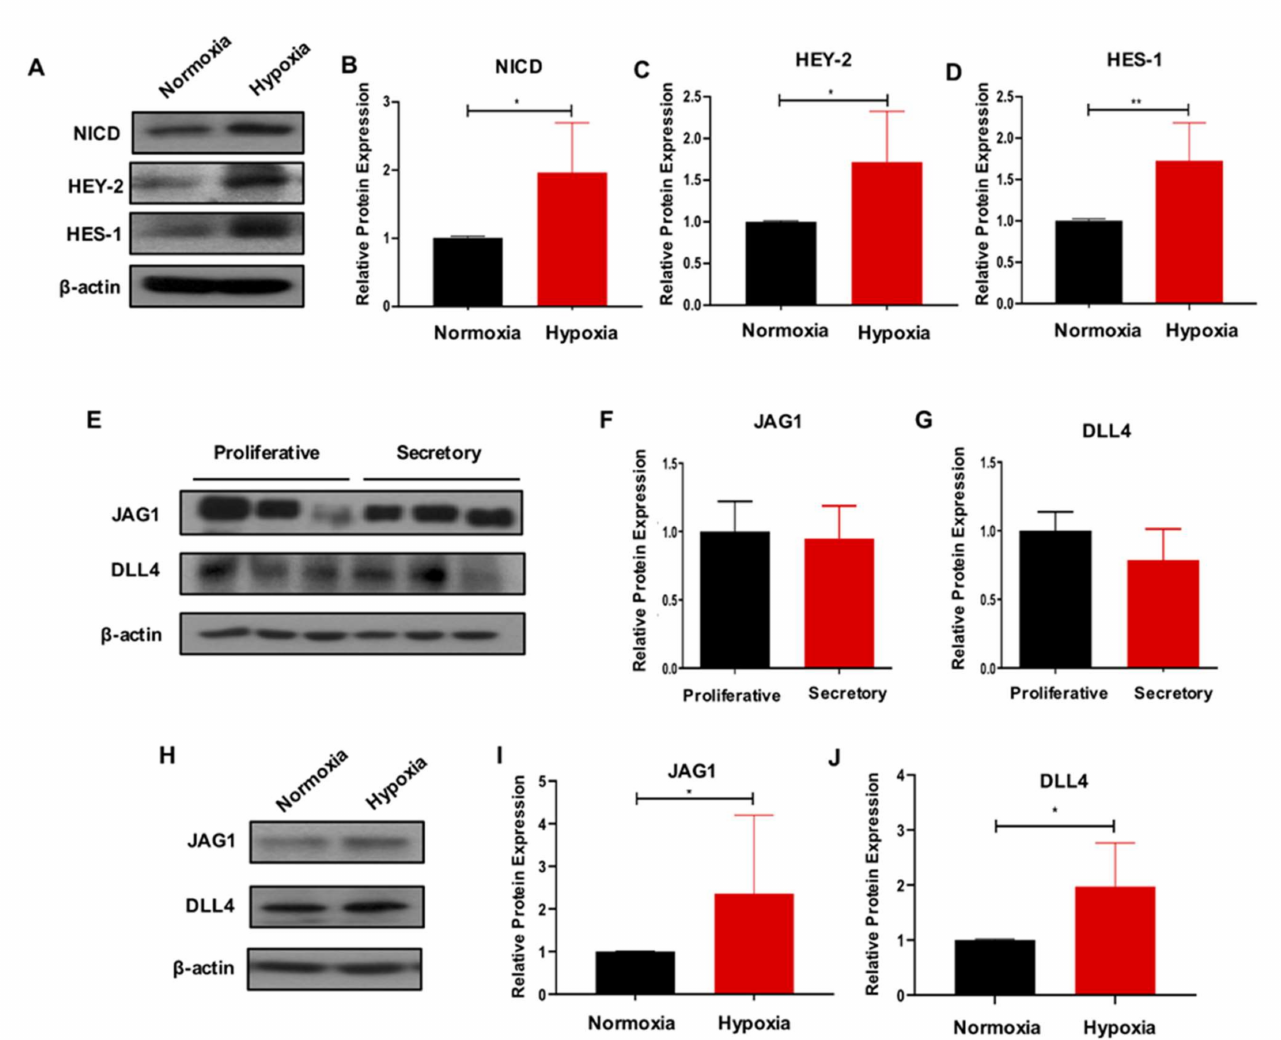
Figure 4. Hypoxia activates Notch signaling in eMSC and upregulates Notch ligands expression in myometrial cells. ( A – D ) Hypoxia activates Notch signaling in eMSC. Representative Western blotting images and quantitative analysis of Notch-related proteins expression in eMSC cultured under normoxia and hypoxia ( n = 5–6). ( E – J ) Hypoxia upregulates Notch ligands in myometrial cells. ( E – G ) Representative Western blotting images and quantitative analysis of Notch ligand protein expression in myometrial cells from different menstrual phases ( n = 3). ( H – J ) Representative Western blotting images and quantitative analysis of Notch ligands expression in myometrial cells cultured in normoxia and hypoxia ( n = 5). Results are presented as mean ± SD; * p < 0.05. ** p < 0.01. Abbreviations: eMSC, endometrial mesenchymal stem-like